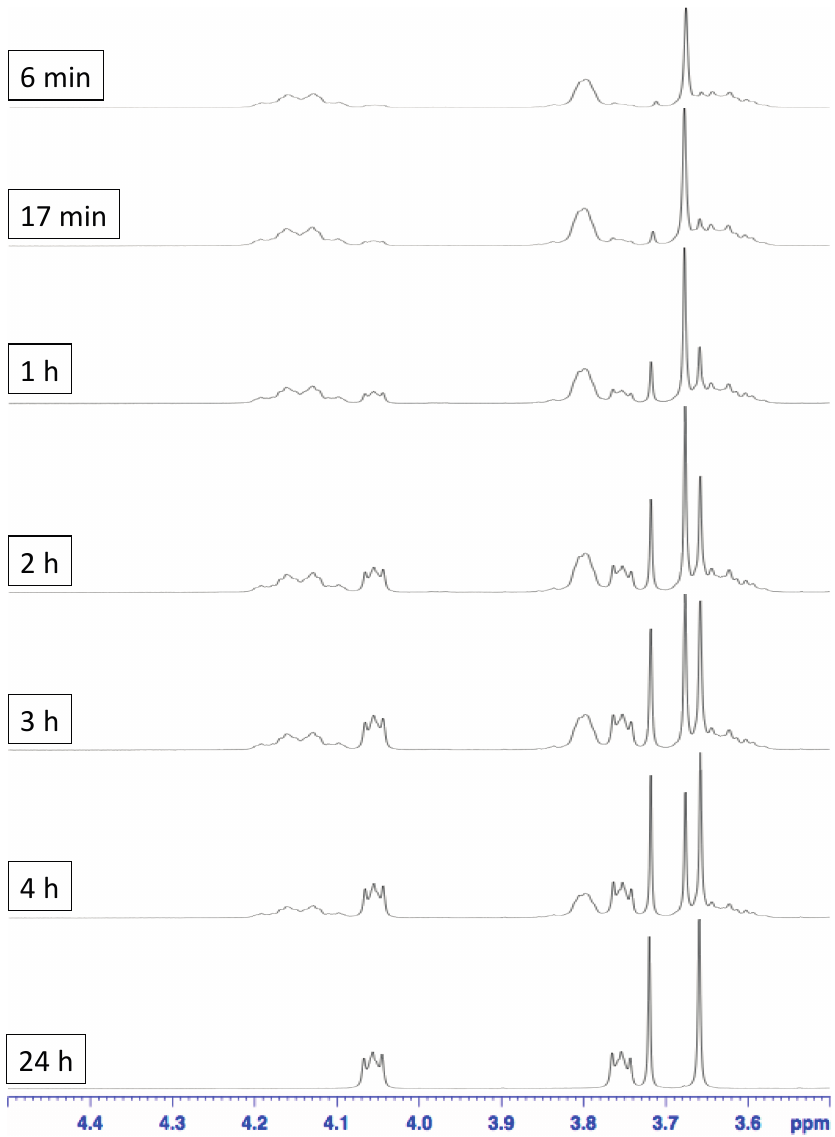
Figure 5. Stacked 1 H NMR spectra (400 MHz, CD 3 SOCD 3 , 298 K) showing the extrusion of DB24C8 macrocycle from the isolated [2]pseudorotaxane DB24C8 ⊃ 1 -H·PF 6 in DMSO- d 6 over